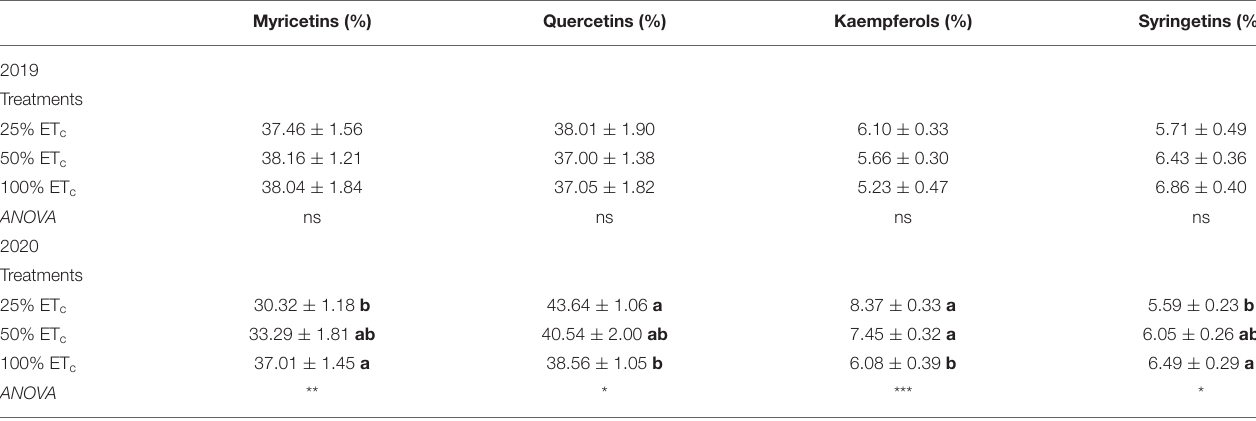
TABLE 4 | Flavonol composition (%) of Cabernet Sauvignon grapevines (clone FPS08) subjected to different replacement of crop evapotranspiration (25, 50, and 100% ET